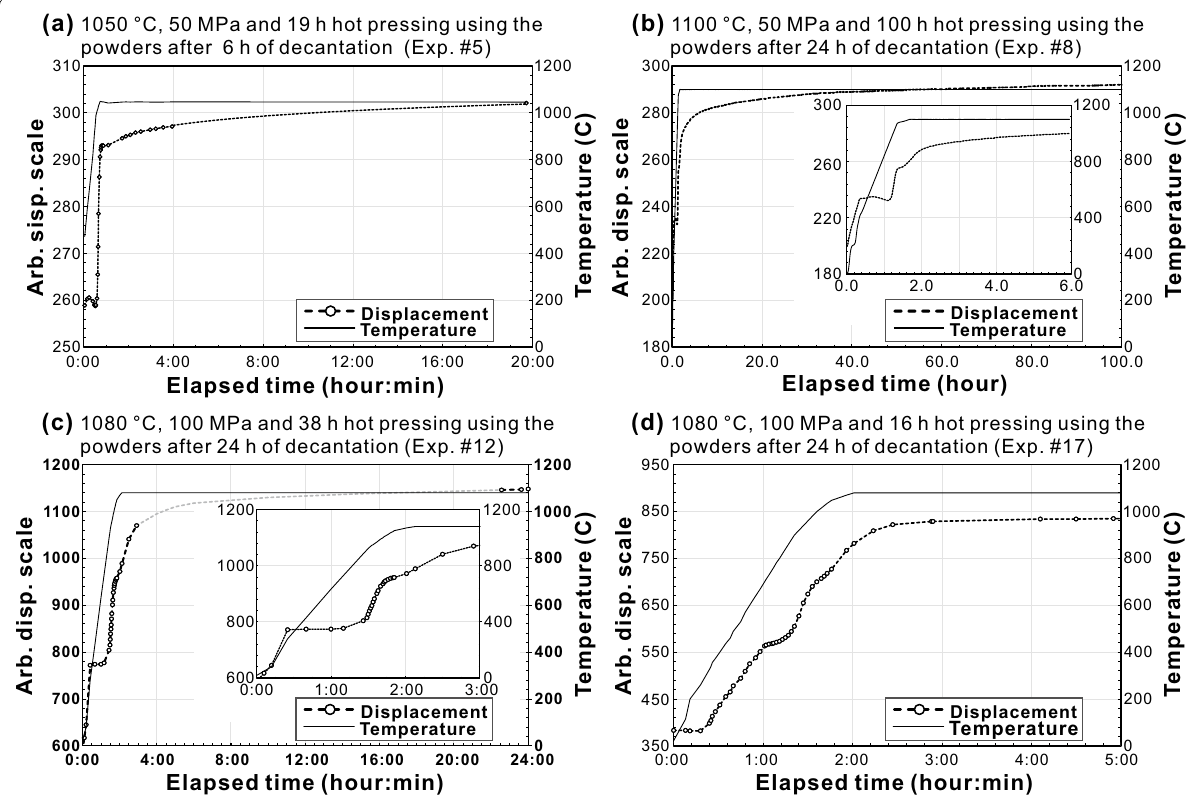
Fig. 7 Shrinkage behaviour during hot pressing. a Shrinkage behaviour of the powders after 6 h of decantation and hot‑pressed at 50 MPa and 1050 °C (Exp. #5). b Shrinkage behaviour of the powders after 24 h of decantation and hot‑pressed without CAS conditions at 50 MPa and 1100 °C (Exp. #8). Inset indicates the shrinkage behaviour for the first 6 h. c Shrinkage behaviour of the powders after 24 h of decantation and hot‑pressed with CAS conditions at 100 MPa and 1080 °C (Exp. #12). Inset indicates the shrinkage behaviour for the first 3 h. d Shrinkage behaviour in the experiment of preparing a green body by slip casting from the powders after 24 h of decantation and hot pressing with CAS conditions at 100 MPa and 1080 °C (Exp. #17). The shrinkage behaviour was manually recorded for the experiments shown in ( a ), ( c ) and ( d ), and the open circles indicate the recorded